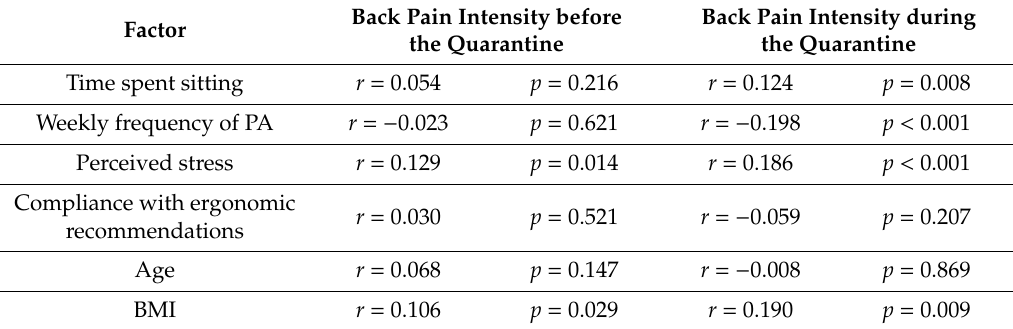
Table 3. Correlations between back pain intensity and personal and environmental factors. Back Pain Intensity before Back Pain Intensity Factor the Quarantine